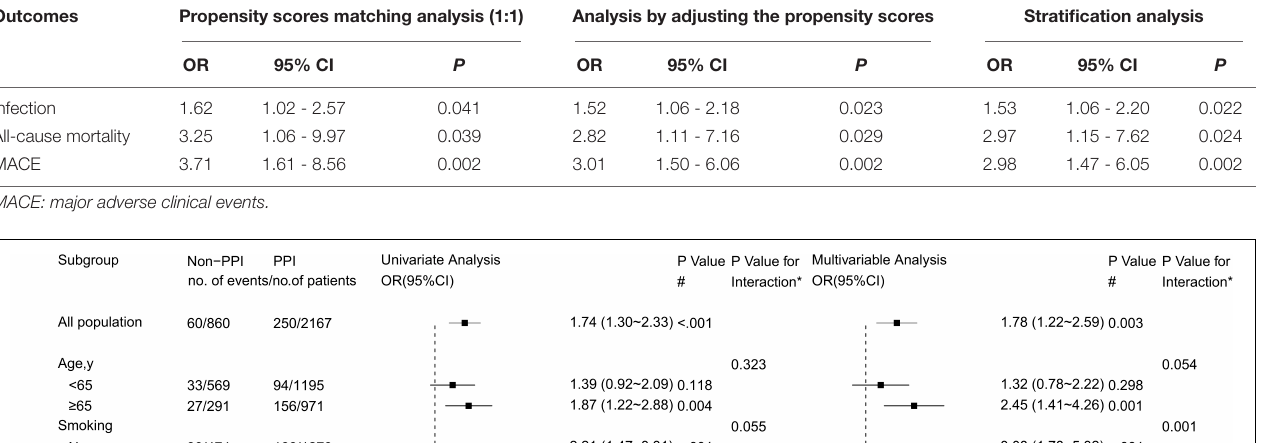
TABLE 4 | Propensity score analysis of in-hospital clinical outcomes. Outcomes Propensity scores matching analysis (1:1)